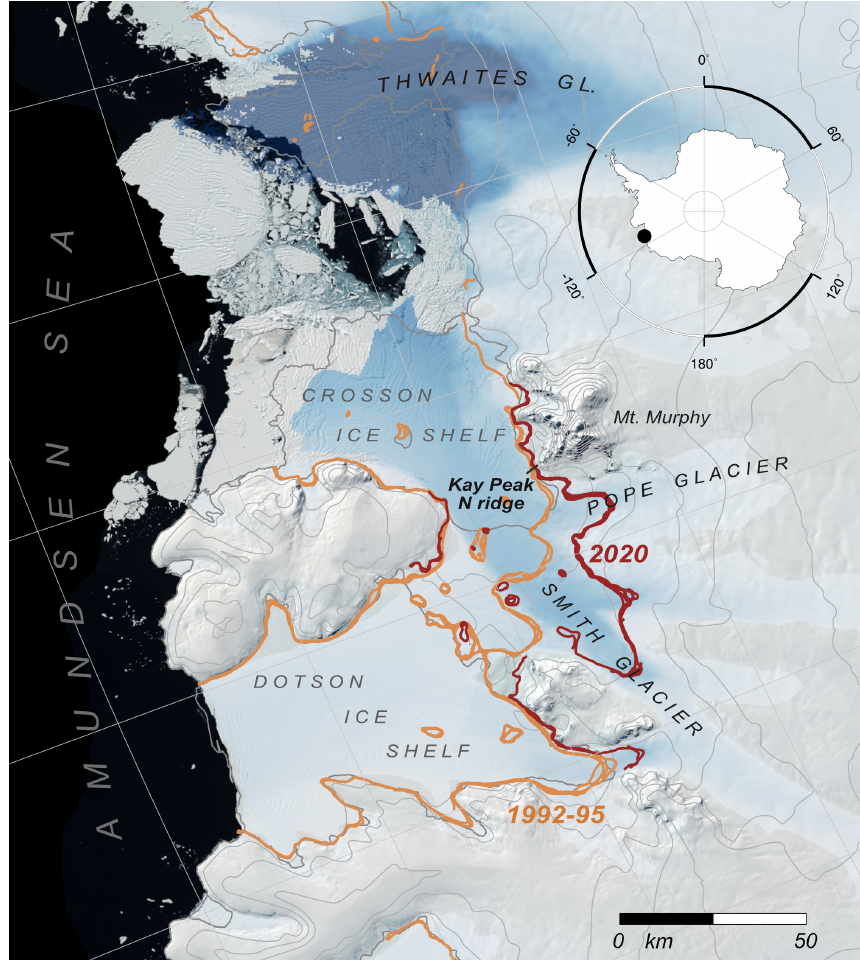
Figure 1. Map of the central Amundsen Sea coast generated using data sets from Quantarctica version 3 (Matsuoka et al., 2021) and showing major glaciers, the drill site at Kay Peak Ridge, and historical grounding line positions in the Thwaites–Pope–Smith Glacier region. The 1992–1995 and 2020 grounding line positions are from Rignot et al. (2011) and Milillo et al. (2022), respectively. The blue shading is a qualitative representation of ice flow velocity and is intended to highlight major